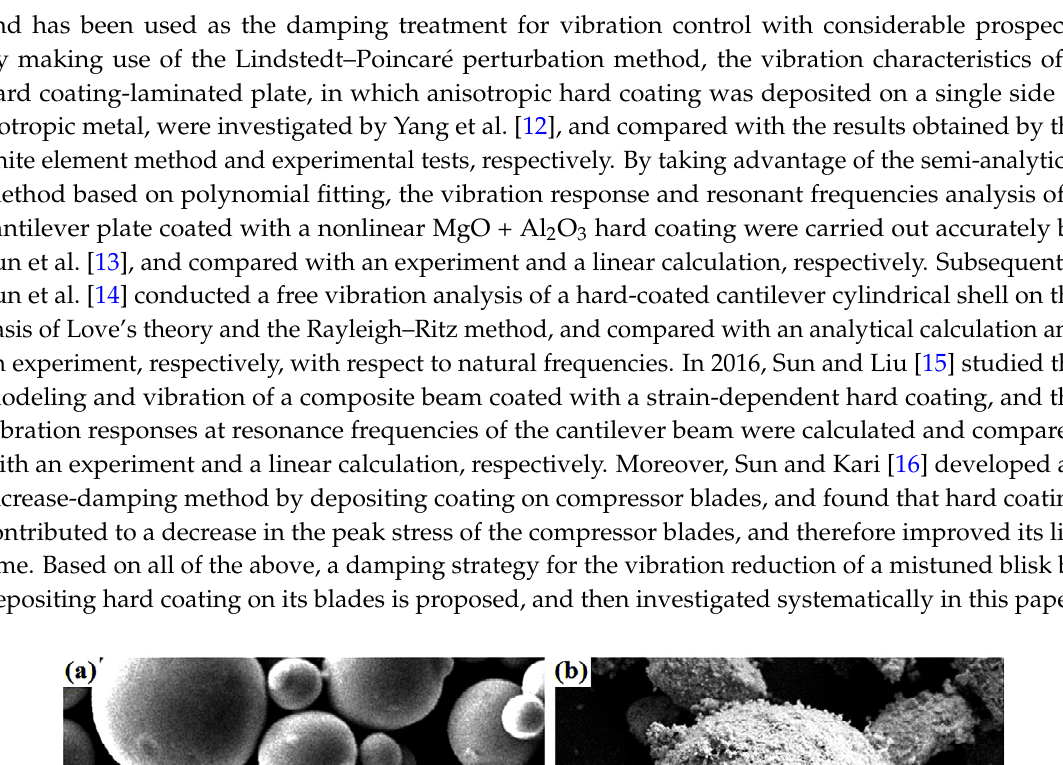
Figure 1. Surface SEM image of ( a ) NiCoCrAlY powders; ( b ) agglomerated nano ‐ YSZ powders and ( c ) cross ‐ sectional SEM image of nano ‐ NiCoCrAlY + YSZ coatings.